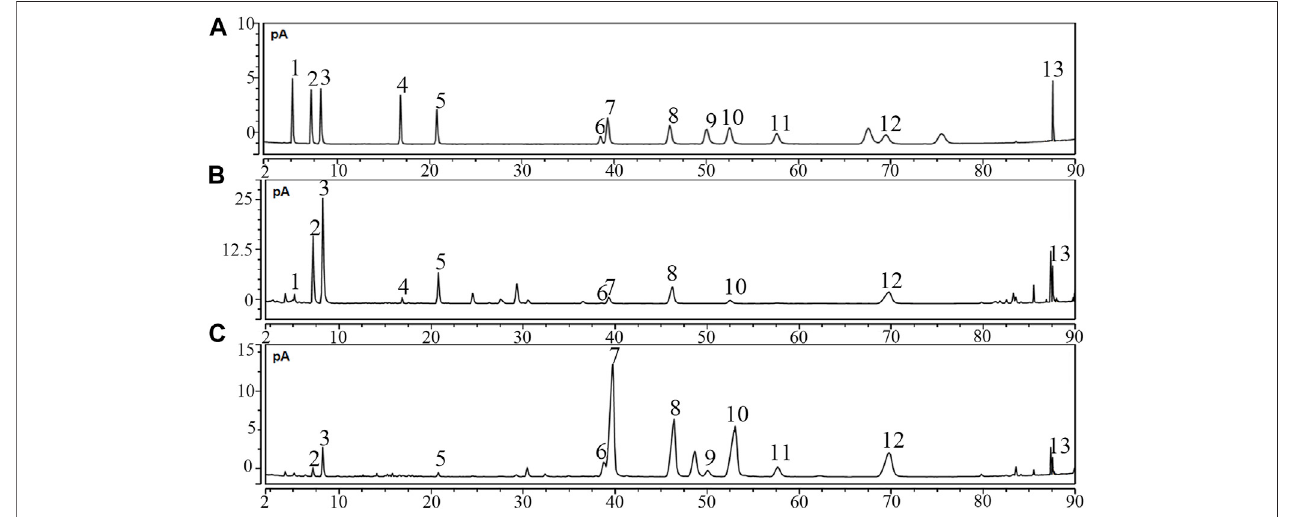
FIGURE 1 | Chromatograms of PDS and PTS by UHPLC-CAD. (A) reference substances; (B) PDS; (C) PTS.